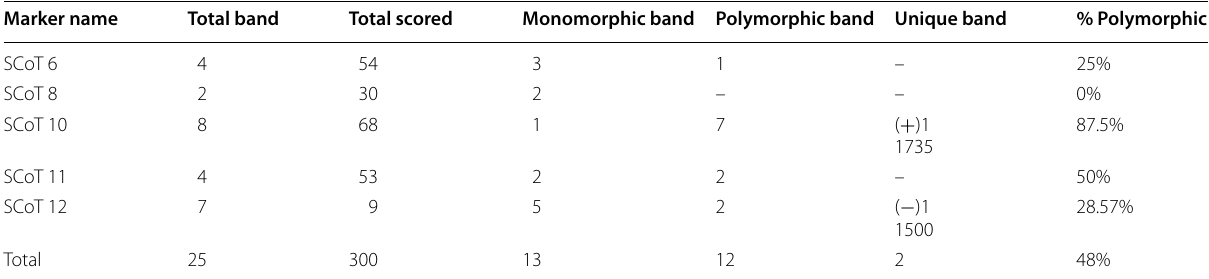
Table 3 The distribution of monomorphic and polymorphic bands generated by the SCoT markers